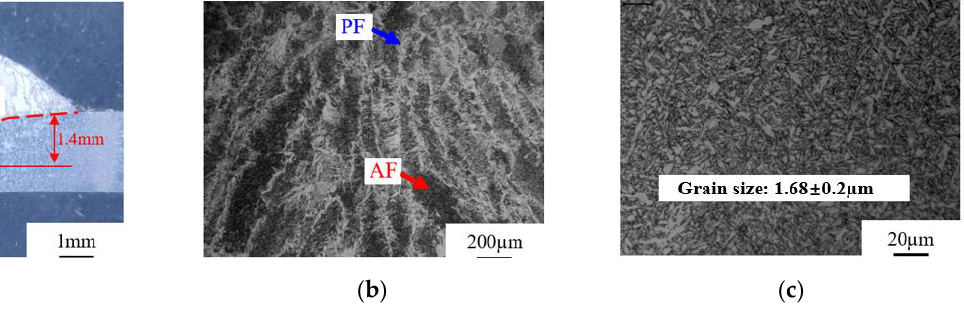
Figure 24. Morphology and structure of weld ( I = 100 A, trapezoid pulse waveform): ( a ) macroscopic morphology of weld; ( b ) microstructure at the center of the weld; ( c ) high magnification image of the AF phase.